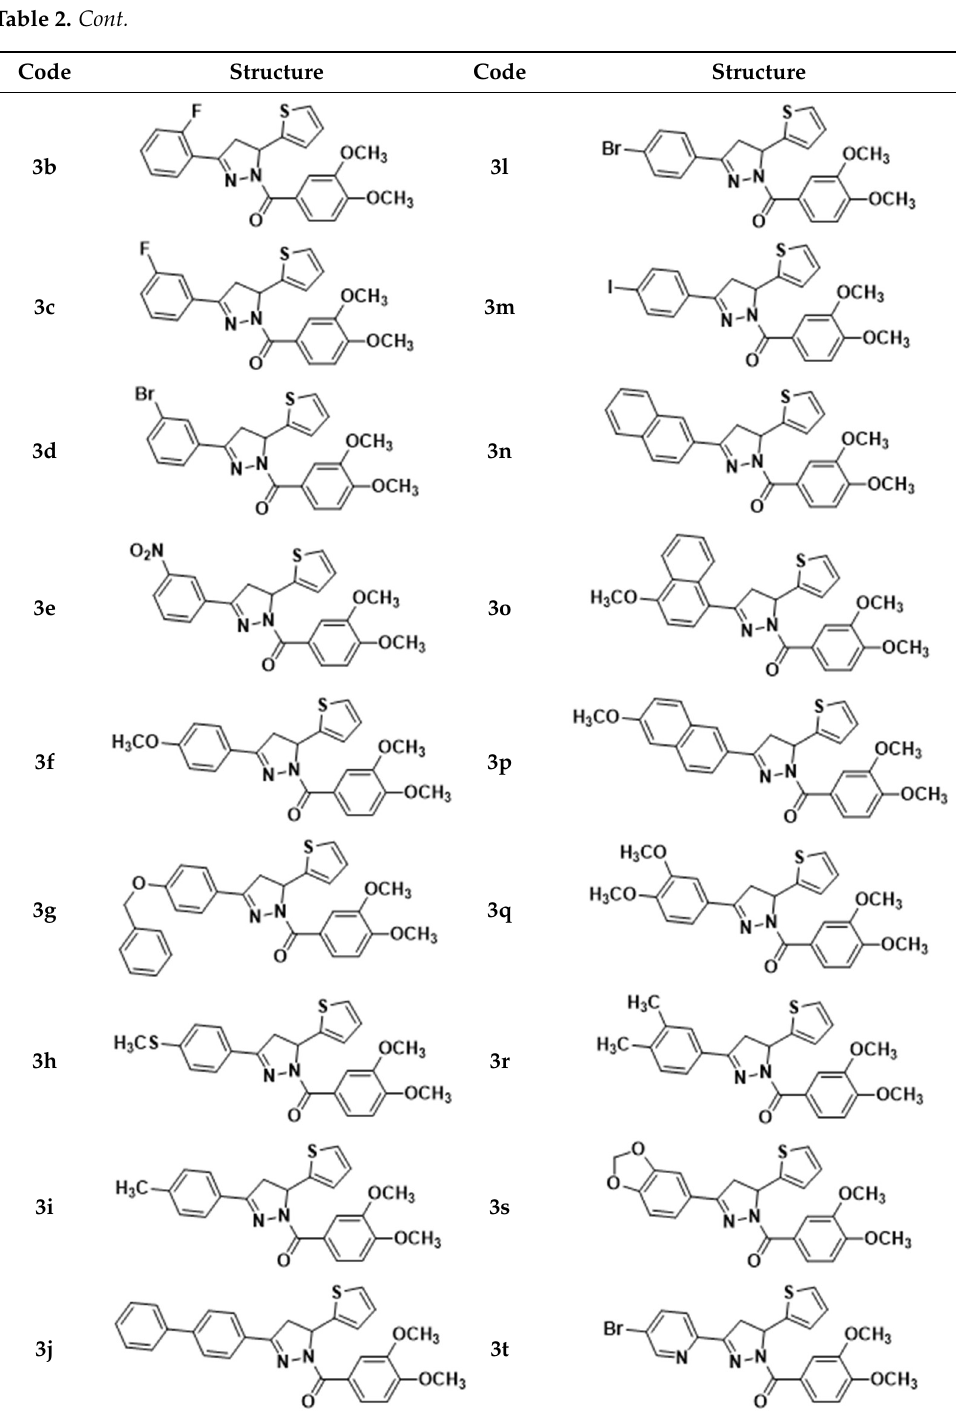
Table 2. The structures of the synthesized compounds 3a – 3t